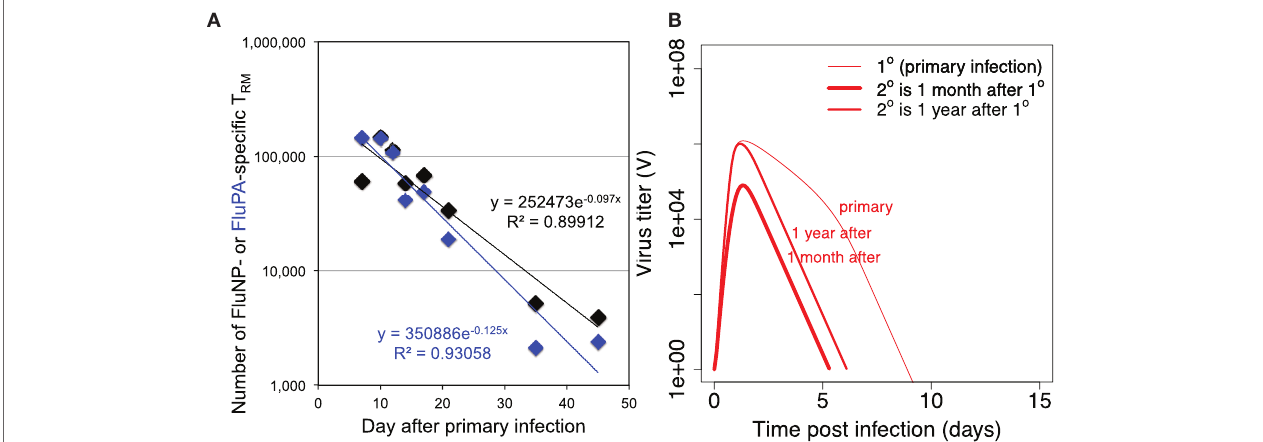
FIGURE 3 | (A) shows the dynamics of loss of resident CD8 T cells after primary infection and estimation of the value of parameter d R (the rate of decay of resident T cells) from the data on mice intranasally infected with primary influenza A virus strain A/HKx31 (H3N2) at 30,000 50% egg infectious dose (EID 50 ). Numbers of lung resident CD8 T cells specific for influenza epitopes FluNP and FluPA were measured at indicated time points. Each data point is the average from 5 to 20 mice. All experiments were completed in accordance with the Institutional Animal Care and Use Committee guidelines of Emory University. (B) shows the dynamics of virus during primary versus recall infections when recall infection happens 30days or 1year after the first infection. For secondary infections the initial values for T P and T R were taken from the corresponding values of variables T P + T M and T R , respectively, in simulation of primary infection with other parameters and initial values as in Tables 1 and 2